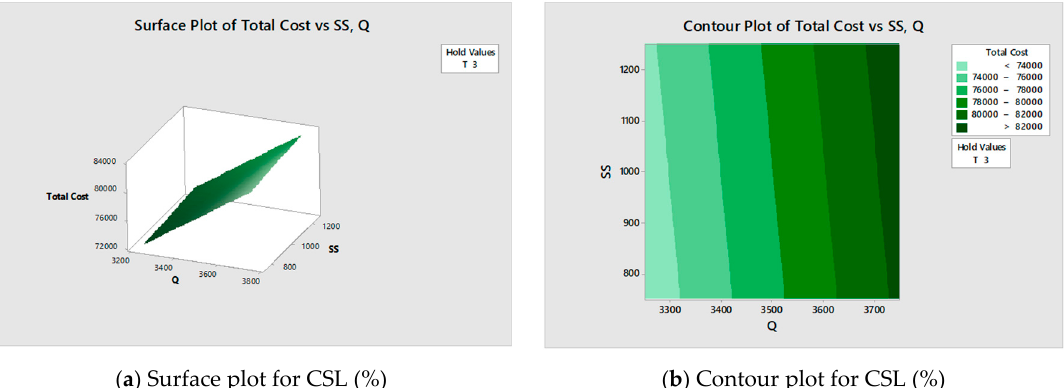
Figure 22. BBD—surface and contour plots for the total cost.